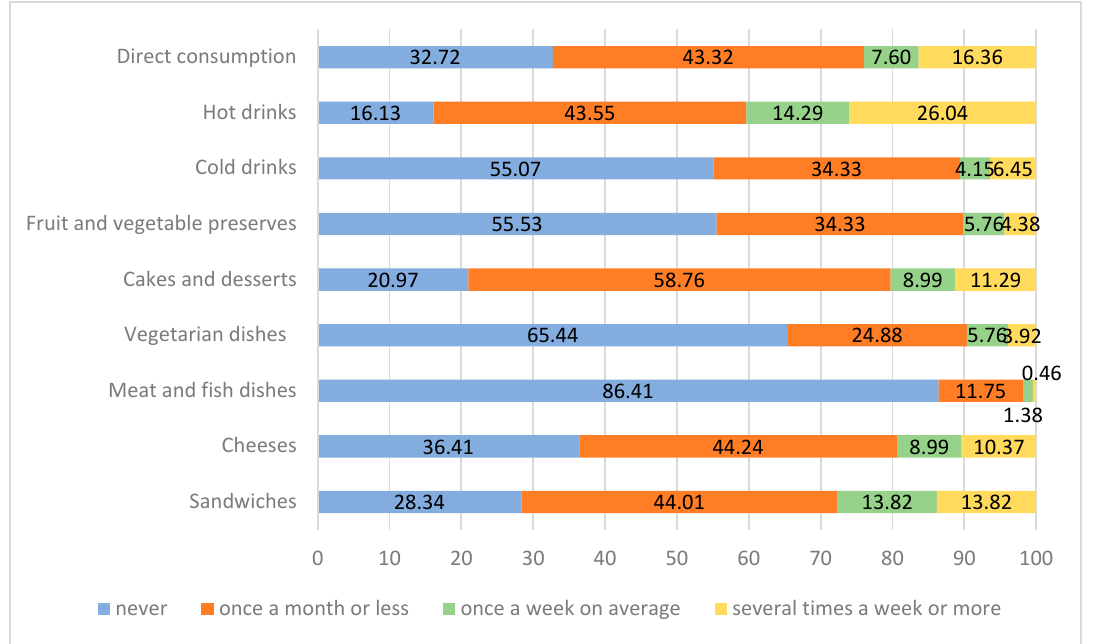
Figure 3. Ways of culinary use of honey (n = 483, data in %). For cosmetic purposes, honey users (n = 209) are most likely to use it to moisturise the skin (23% at least once a month), to soothe irritation (19.1%), to cleanse the skin (18.25), to improve skin elasticity (17.7%), and to stop the ageing process (16.8%). Honey is least frequently used for anti-acne therapy and skin cleansing, with 74.6% and 65.1% of respondents declaring that they never use honey for these purposes (Figure 4).